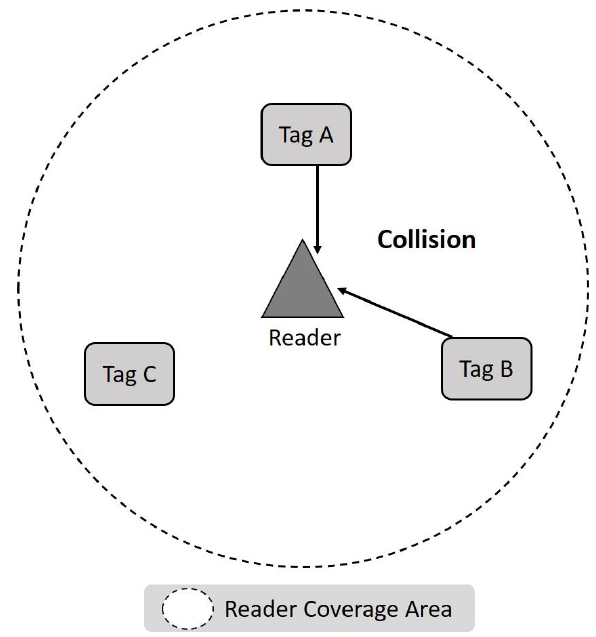
Figure 2. Collisions in a radio-frequency identification (RFID) system .